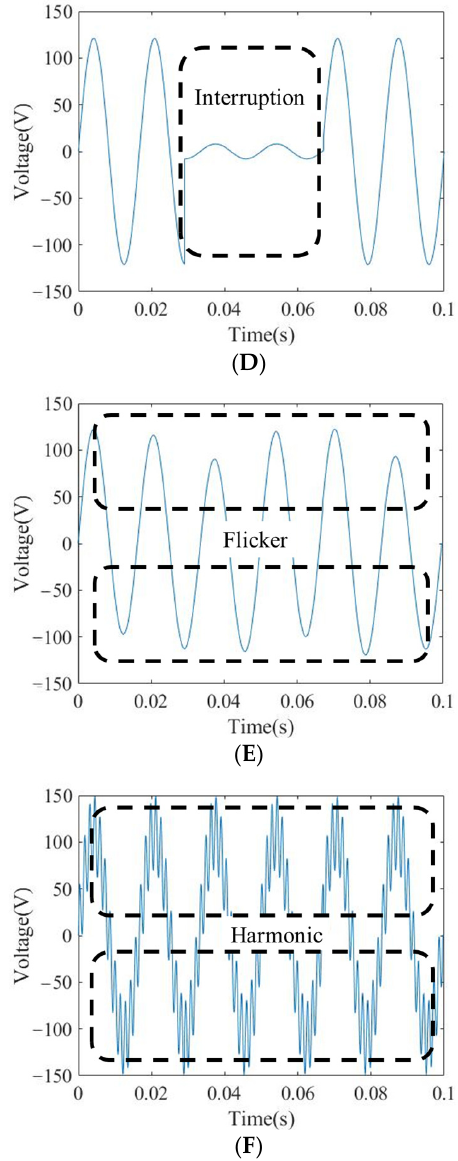
Figure 7. ( A ) Normal voltage. ( B ) Sag of voltage signals to 55 V during 0.029~0.067 s. ( C ) Voltage swell of voltage signals to 152.57 V during 0.029~0.067 s. ( D ) Interruption of voltage signals to 8.03 V during 0.029~0.067 s. ( E ) Flicker phenomenon of voltage signals. ( F ) Harmonic distortions of voltage signals.